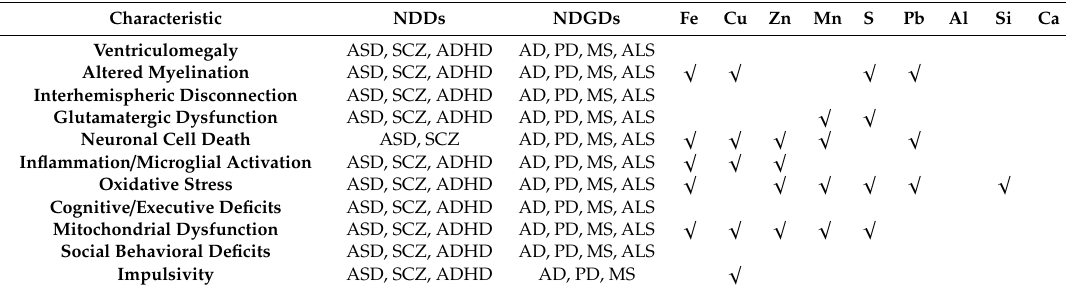
Table 1. Shared characterristics of neurodevelopment disorders and neurodegenerative diseases and current understanding of the impact of inhaled nanoparticulate metals in reproducing these